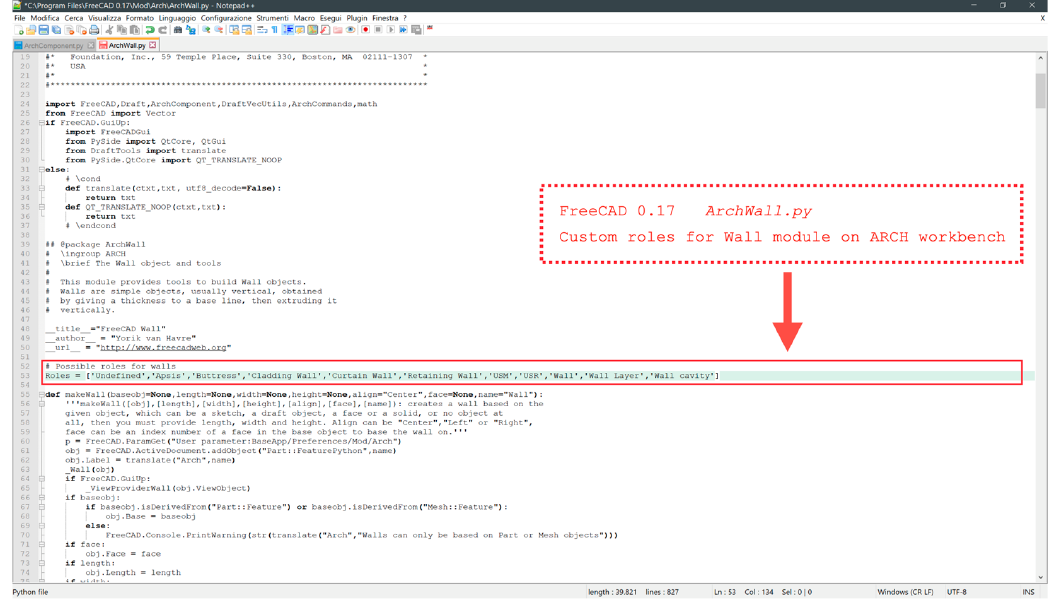
Figure 1. Proposal extension of ifcRole / ifcType related to Python files of ARCH elements inside FreeCAD.